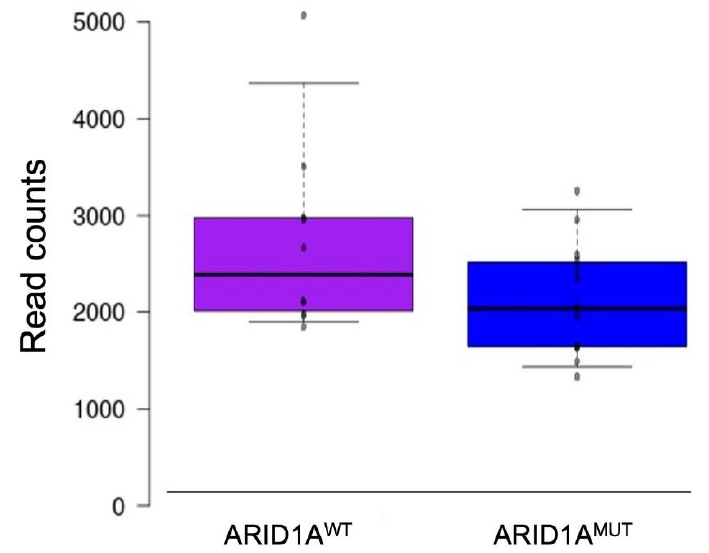
Figure 2. ARID1A expression between wildtype and mutant patients by RNAseq. WT : ARID1A wildtype samples; MUT : ARID1A mutant samples.